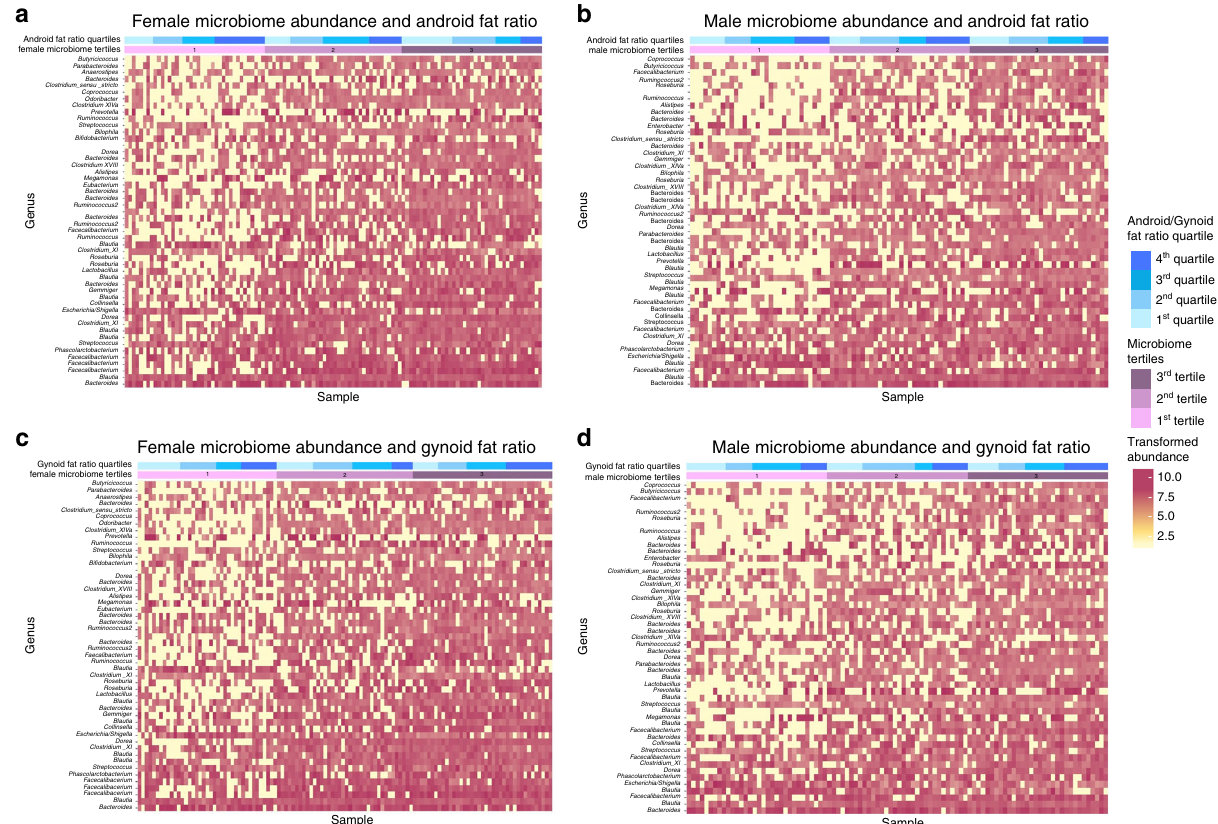
Fig. 1 The association of microbiome abundance and fat ratio. This fi gure shows the global relationship between microbiome abundance and fat distribution in men and women. The top bar indicates the distribution of android and gynoid fat ratios within each microbiome abundance tertile. The blue gradient from light to dark encode the quartiles of the fat ratio from the lowest to the highest. The second bar represents the microbiome abundance tertiles. From light to dark purple, it indicates the lowest to the highest microbiome abundance tertiles. The heatmap contains the top 50 most abundant microbial taxa in men and women ranked from the most abundant to the least bottom up. They compose the rows of the heatmap. Each column represents one sample. The color gradient indicates the abundance of a microbial taxa in a particular sample. Panels a , b show the relationships between microbiome abundance and android fat ratio in women and man, respectively. Similarly, panels c , d show the associations between microbiome abundance with gynoid fat ratio in women and men